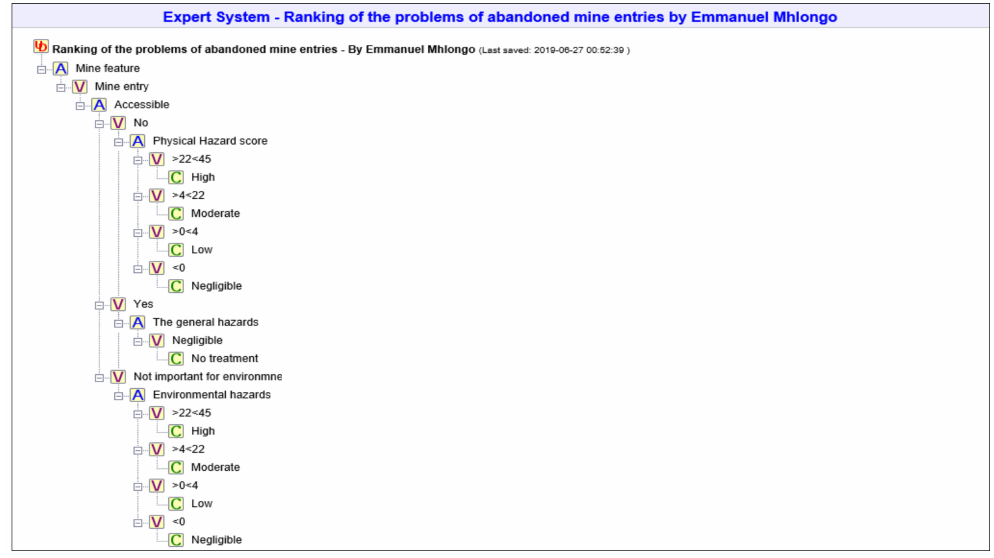
Figure 3. The structure of the decision tree for the ES-RAME. Table 4. The decision table of the